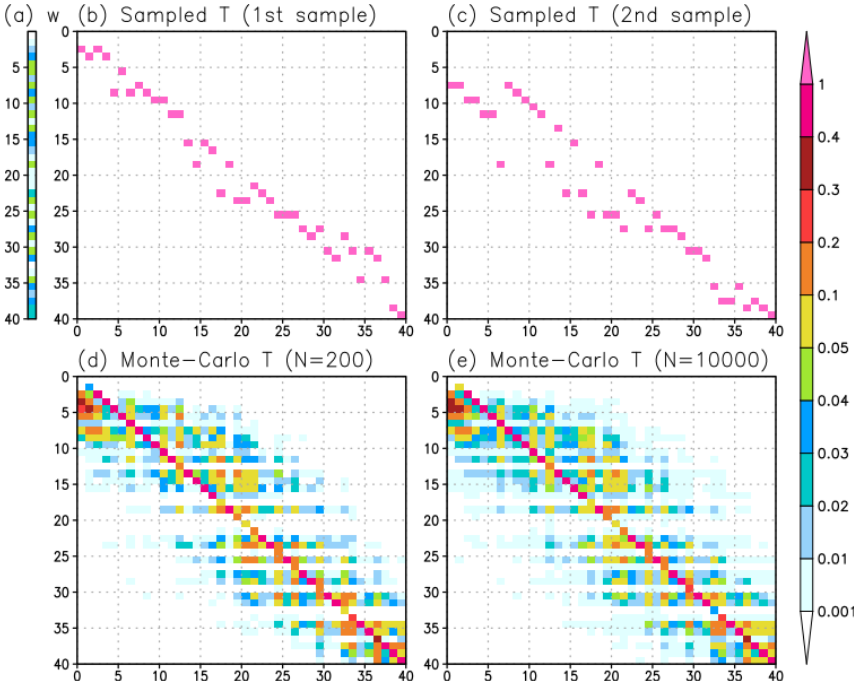
Figure 1. Examples of the resampling matrix in the case of 40 particles with a given weight generated by uniform random numbers. (a) Weight for 40 particles. (b, c) Examples of sampled resampling matrices by Algorithm 1 using different random numbers r . (d, e) Resampling matrices using the Monte Carlo stochastic approach with 200 and 10000 sampled matrices,